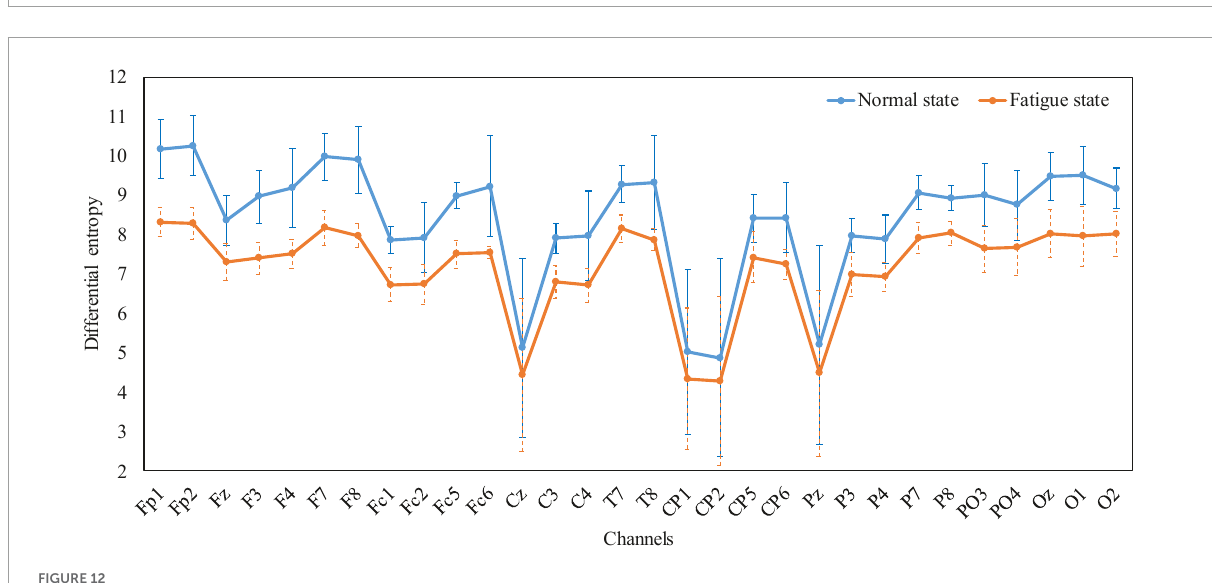
FIGURE12 Line graph of the average DE characteristics of all subjects in normal and fatigue states,